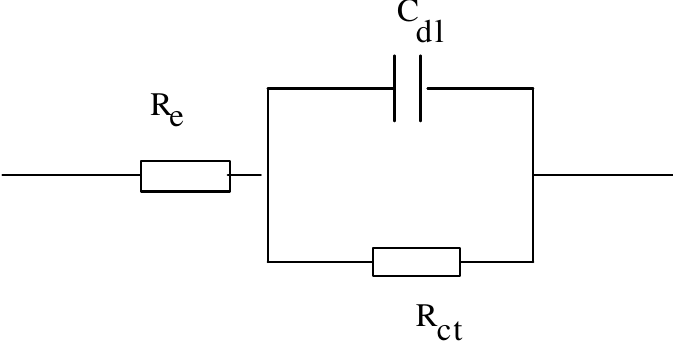
Figure 1b . Equivalent circuit which is composed with the capacitance C dl which is the double